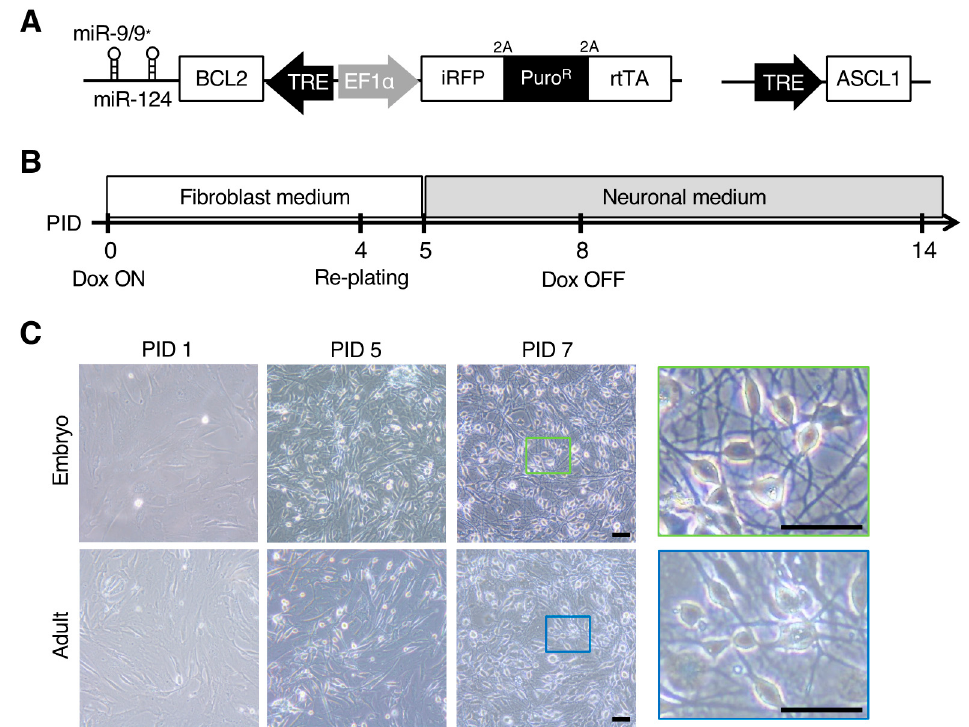
Figure 1. Neuronal induction of marmoset fibroblasts by overexpressing microRNA-9/9* and microRNA-124 (miR-9/9*-124) and Achaete-Scute family bHLH transcription factor 1 (ASCL1). ( A ) Left: PiggyBac transposon vector containing (1) infrared fluorescent protein (iRFP), puromycin resistance (Puro R ), and reverse tetracycline transactivator (rtTA) under the control of the elongation factor 1 α (EF1 α ) promoter, and (2) human B-cell lymphoma 2 (BCL2) and miR-9/9*-124 under the control of the tetracycline response element (TRE) promoter. Right: Lentiviral vector containing ASCL1 under the control of the TRE promoter. ( B ) Time course for induction. After the transduction of miR-9/9*-124 and ASCL1 , doxycycline (Dox) was added to start induction. At post induction day (PID) 4, the cells were re-plated on dishes with neuronal cell-optimized coating. The culture medium was replaced with neuronal medium supplemented with small molecules that enhance reprogramming at PID 5. The cells were analyzed within ~2 weeks. ( C ) Morphological changes of neuron-like cells from embryonic and adult fibroblasts during the induction process. The cells retained fibroblast morphology until re-plating at PID 4. After re-plating and neuronal medium change, these cells acquired neuron-like morphology. Spherical cell bodies and neurite-like structures were observed in these cells. Scale bars, 50 µ